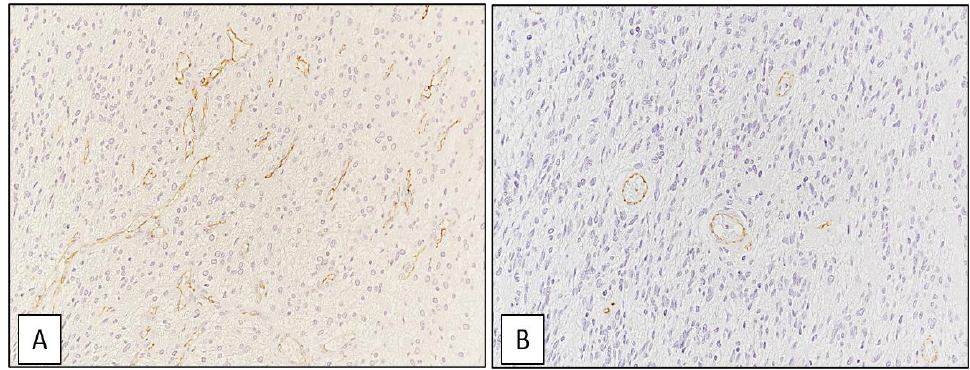
Figure 8. GBM tissue sample. High ( A ) and low ( B ) MVD count on GBM tissue (immunoperoxidase staining; original magnifications 200×).